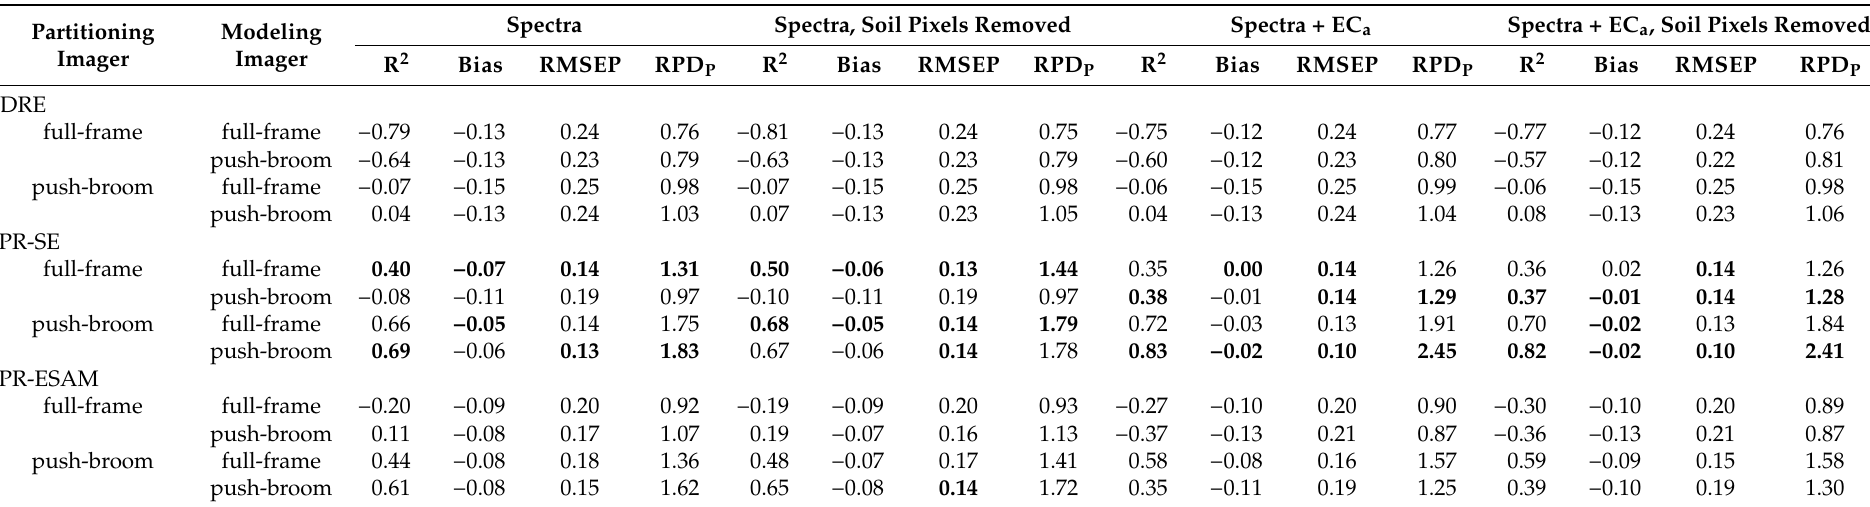
Table 3. Nitrogen content prediction performance metrics of individual model families across the testing datasets according to the device which provided spectra for dataset partitioning and for model training. The four column blocks examine the effects of removing soil pixels from the hyperspectral imagery prior to model training or augmenting the spectral data with measurements of apparent soil electrical conductivity. The three row blocks correspond to the predicted variables. The values of bias and RMSEP are in pp. The individual rows of each block compare the performance of the cameras and predictive model formulations. The results with the best metrics for each training dataset are marked in